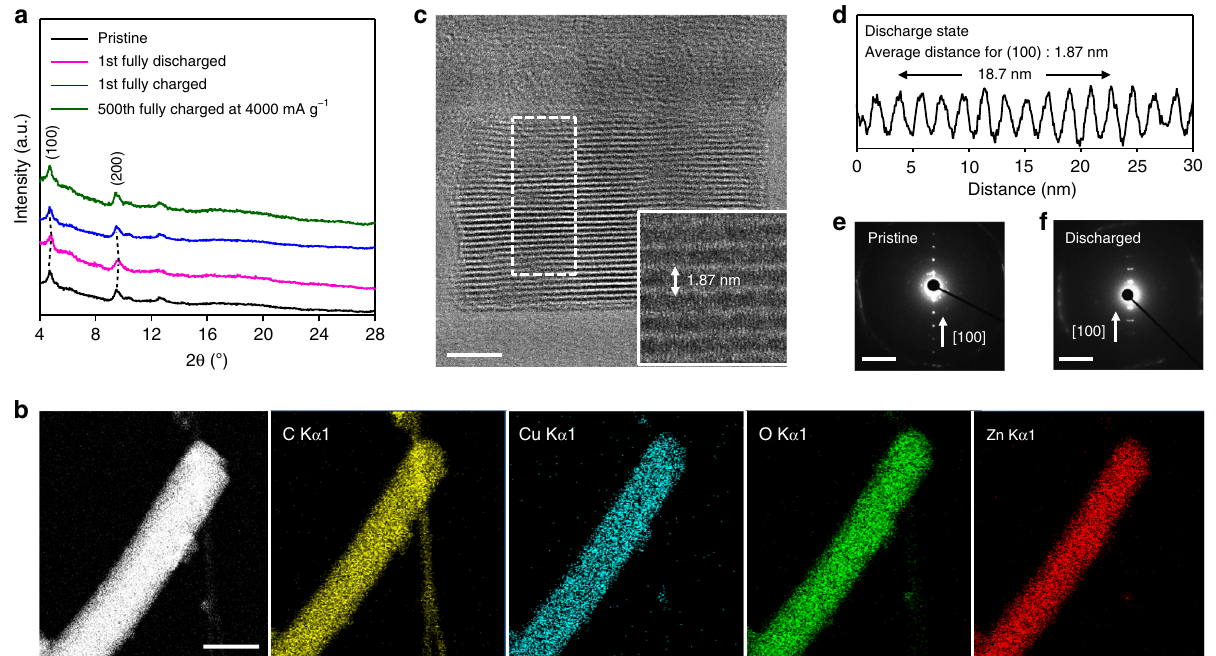
Fig. 5 Structure analysis during discharge – charge. a PXRD patterns of the Cu 3 (HHTP) 2 electrode in the pristine, fi rst fully discharged/charged states at a rate of 50 mA g − 1 , and 500th fully charged states at a rate of 4000 mA g − 1 . b Scanning transmission electron microscopy (STEM) image of the fully discharged Cu 3 (HHTP) 2 alongside its EDX elemental mapping with respect to C, Cu, O, and Zn, suggesting uniform Zn insertion over the electrode, scale bar: 100 nm. c An LD-HRTEM image of discharged Cu 3 (HHTP) 2 viewed down the [010] zone axis. An inset in ( c ) shows a magni fi ed area depicting the (100) plane, scale bar: 20 nm. d Measurements of the (100) interplanar distances from the white boxed area in ( c ) indicate the average d 100 = 1.87 nm. e , f SAD patterns from Cu 3 (HHTP) 2 at ( e ) pristine and ( f ) discharged states used to con fi rm the interplanar distances of (100). The arrows and scale bar indicate the [100] direction and 2 nm − 1 ,